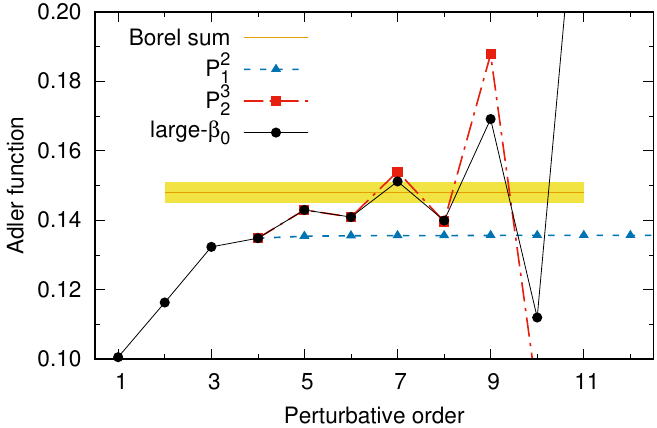
Figure 1. Results for the perturbative expansion of the Adler function in large- (cid:12) 0 (solid line) and using the P 2 ( u ) (dashed line) and P 3 ( u ) (dot dashed line). The result of the Borel sum of the series is 1 2 displayed with a band that represents its ambiguity. In all (cid:12)gures we use (cid:11) s ( m 2